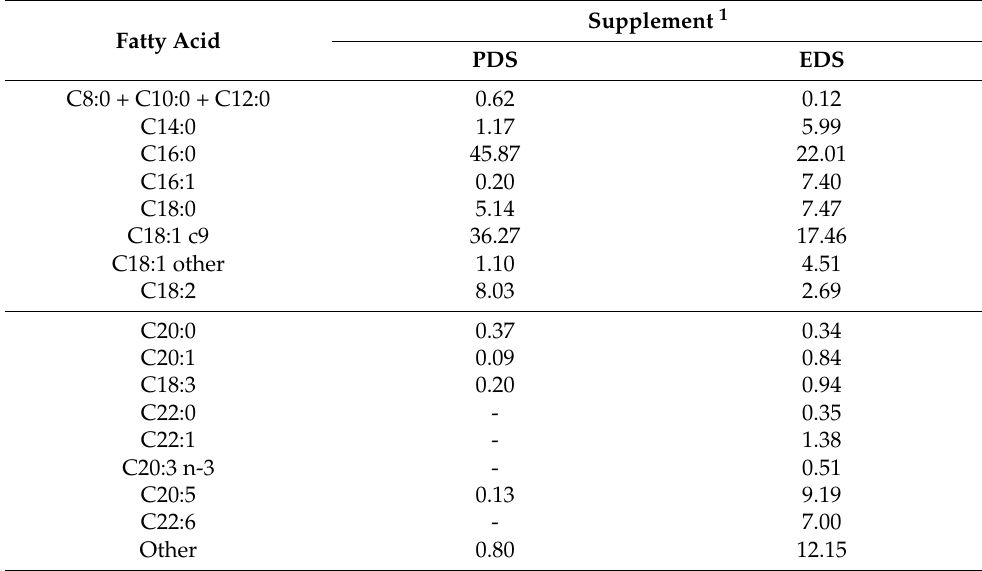
Table 2. Fatty acid profile (% of total fatty acid) of Ca salts used to supplement pregnant ewes during the last 50 days of